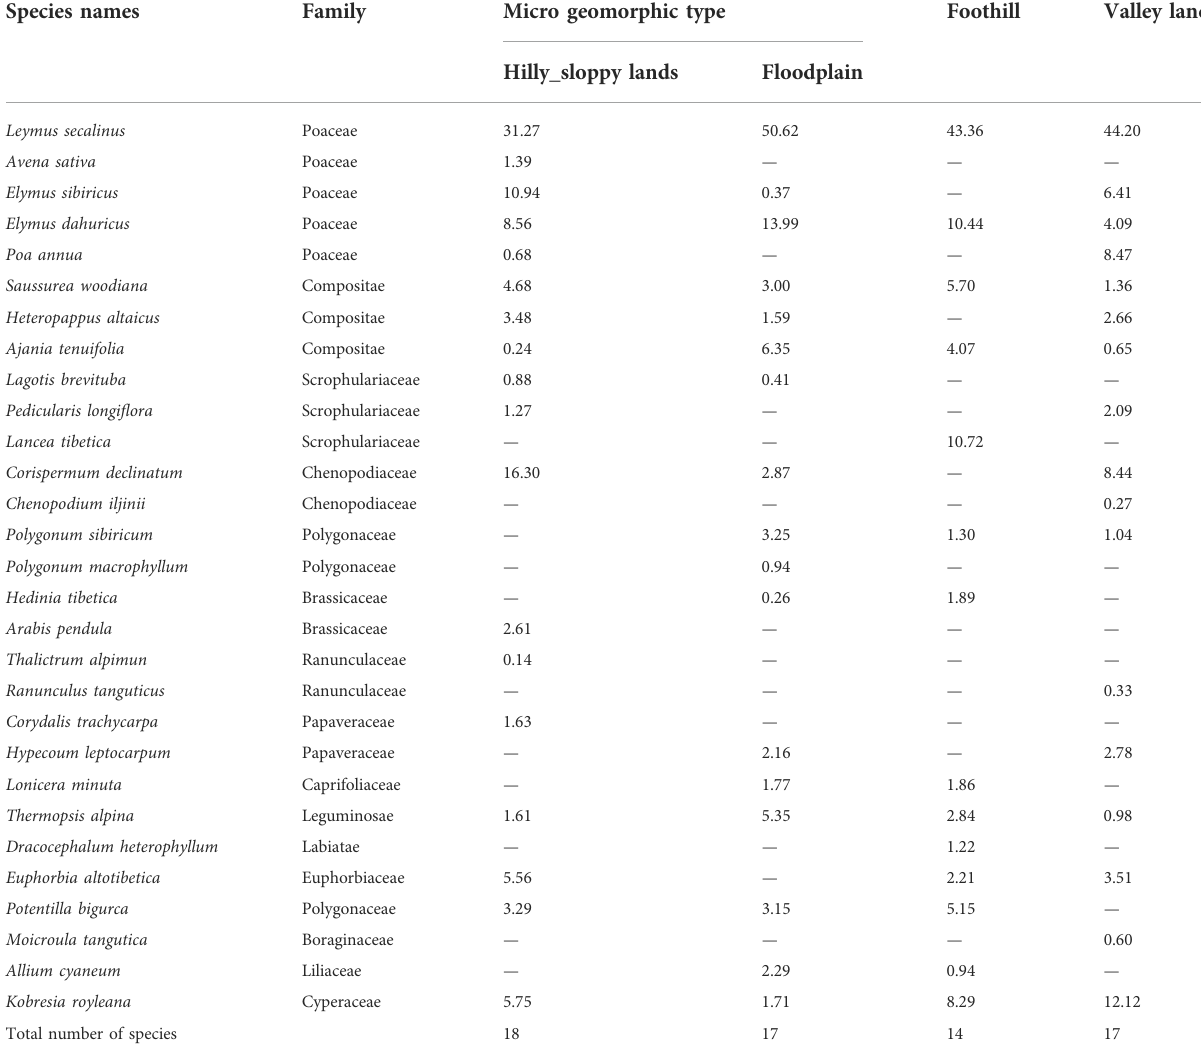
TABLE 1 Species important value of sandy alpine grassland community in different